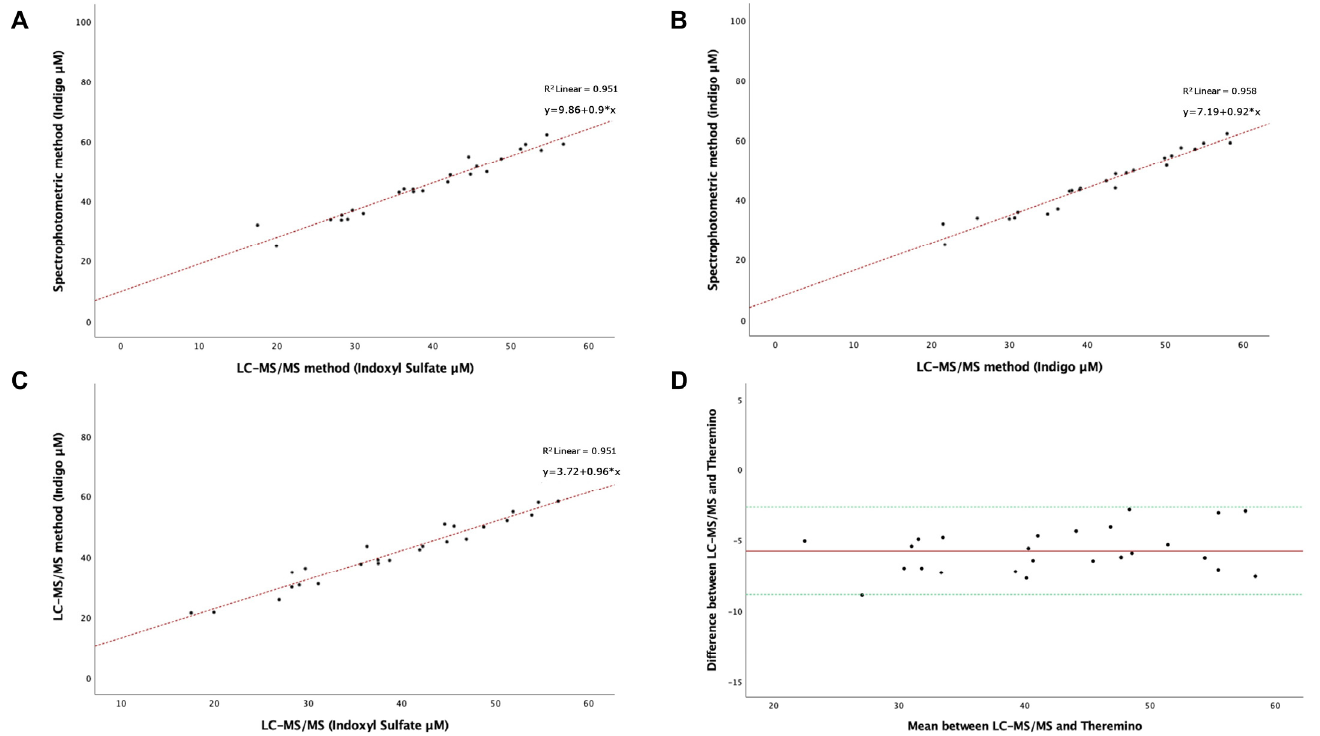
Figure 4. ( A – C ) Linear regression analysis of the relationship between the LC-MS/MS method and colorimetric assay performed using Theremino on IS and IS-derived Indigo in HD patients. ( D ) Evaluation of the agreement by the Bland–Altman plot using the difference and the mean among the data of the two methods. Upper and lower green lines represent the region of agreement, and the red line represents the bias between methods ( − 5.7732) obtained by the mean of the difference of results.